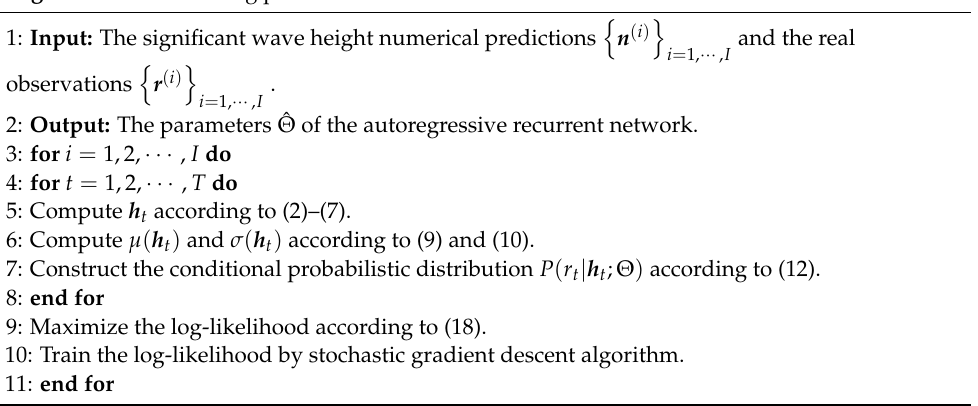
Algorithm 1 The training procedure of the N-LSTM